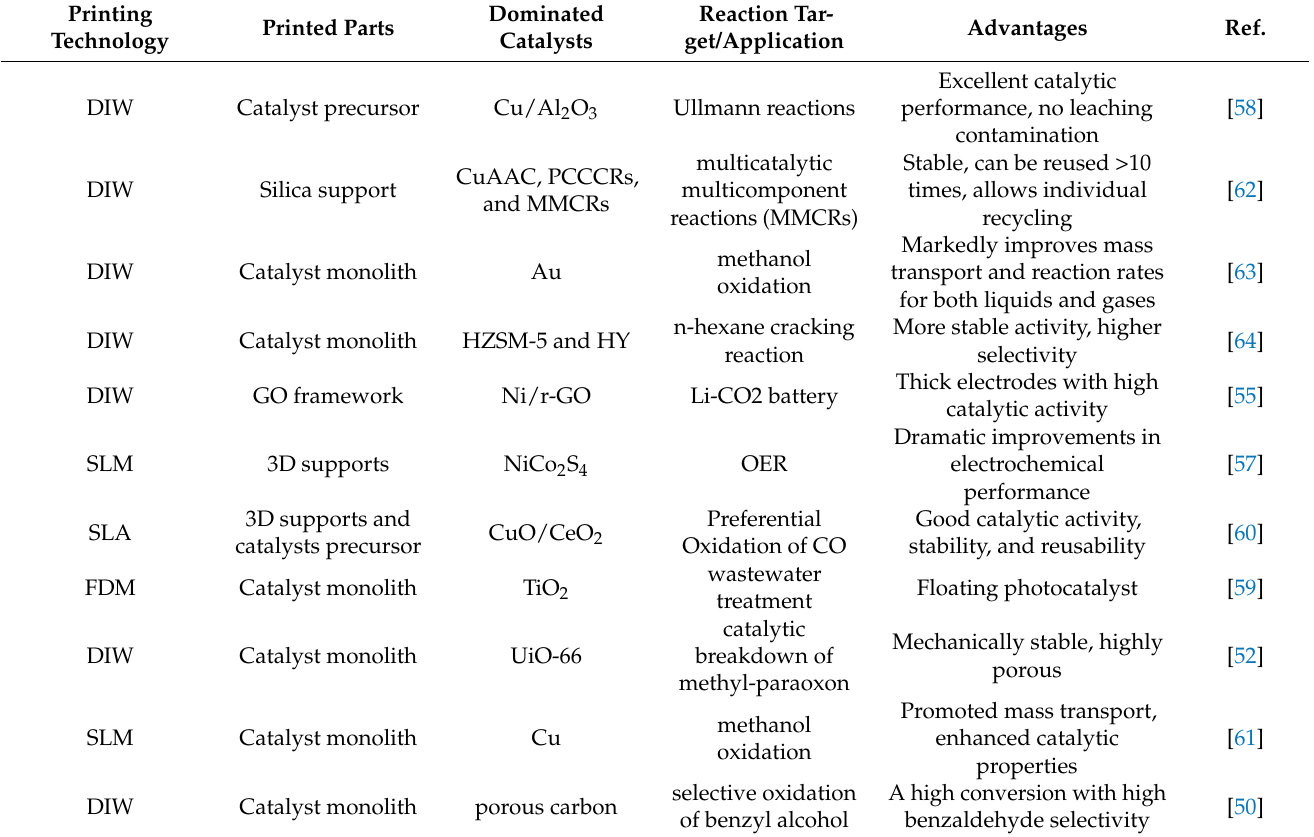
Figure 5. ( a ) Digital images of 3D Cu-Mn scaffold (left) and dealloyed 3D Cu scaffold, ( b ) SEM images, and ( c ) catalytic performance of 3D hierarchical Cu catalyst [61]. Reproduced with permission from ref. (Zhang, 2019) Copyright, 2019, John Wiley and Sons. Table 1. Summary of 3D printed